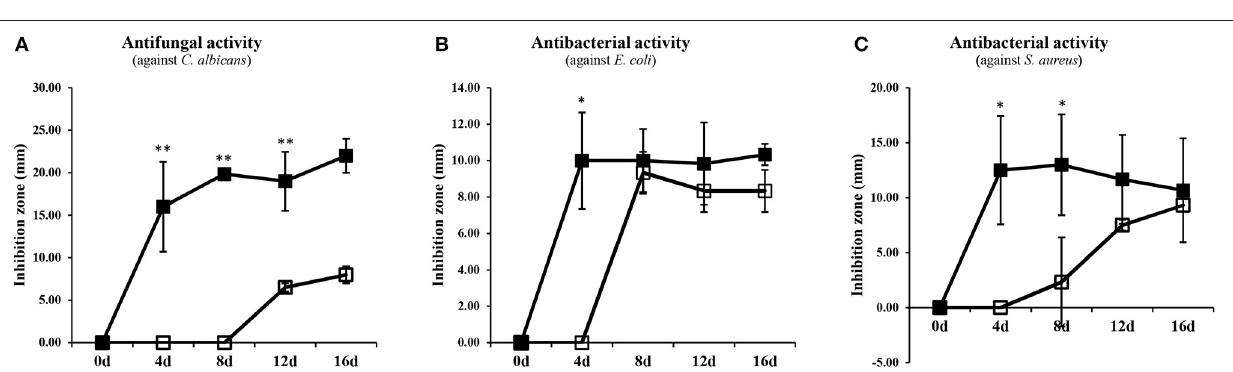
FIGURE 3 | (A) PLS-DA loading plots of SSF and SmF samples analyzed using UHPLC-LTQ-IT-MS/MS. , Solid-state fermentation; , Submerged fermentation; , Coumarins; , Terpenoids; , Unsaturated fatty acids; , Diketopiperazine; , Anthraquinone; , Saturated fatty acid; , Organic acid. (B) The structure of compounds significantly produced in (a) solid-state fermentation and (b) submerged fermentation.